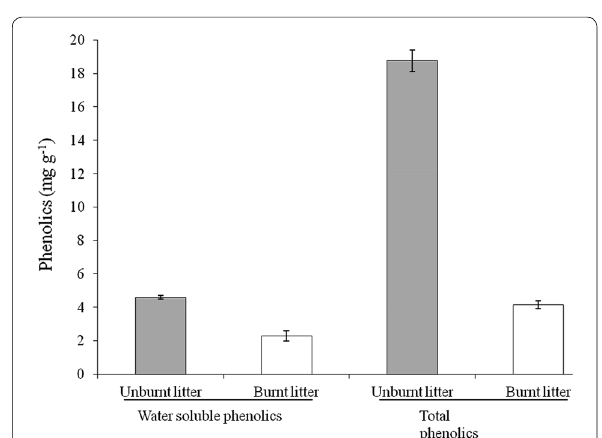
Fig. 3 Total phenolics (TP) and water soluble phenolics (WSP) Phrag- mites australis litter (unburnt versus burnt). Values are means ard errors ( n 3 =